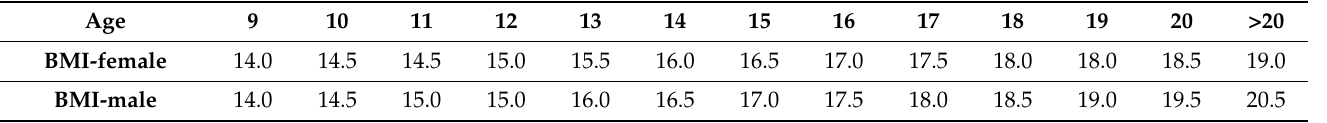
Table 3. Interpretation of BMI compared to age and gender norms